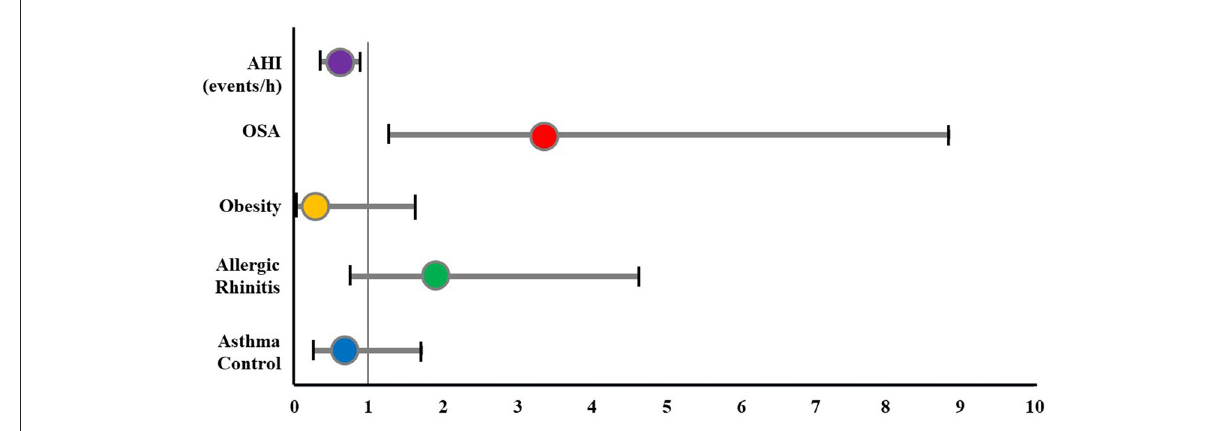
FIGURE4 The odds ratio of ADHD for study subjects. ADHD, attention deficit and hyperactivity disorder; AHI, apnea-hypopnea index; OSA, obstructive sleep